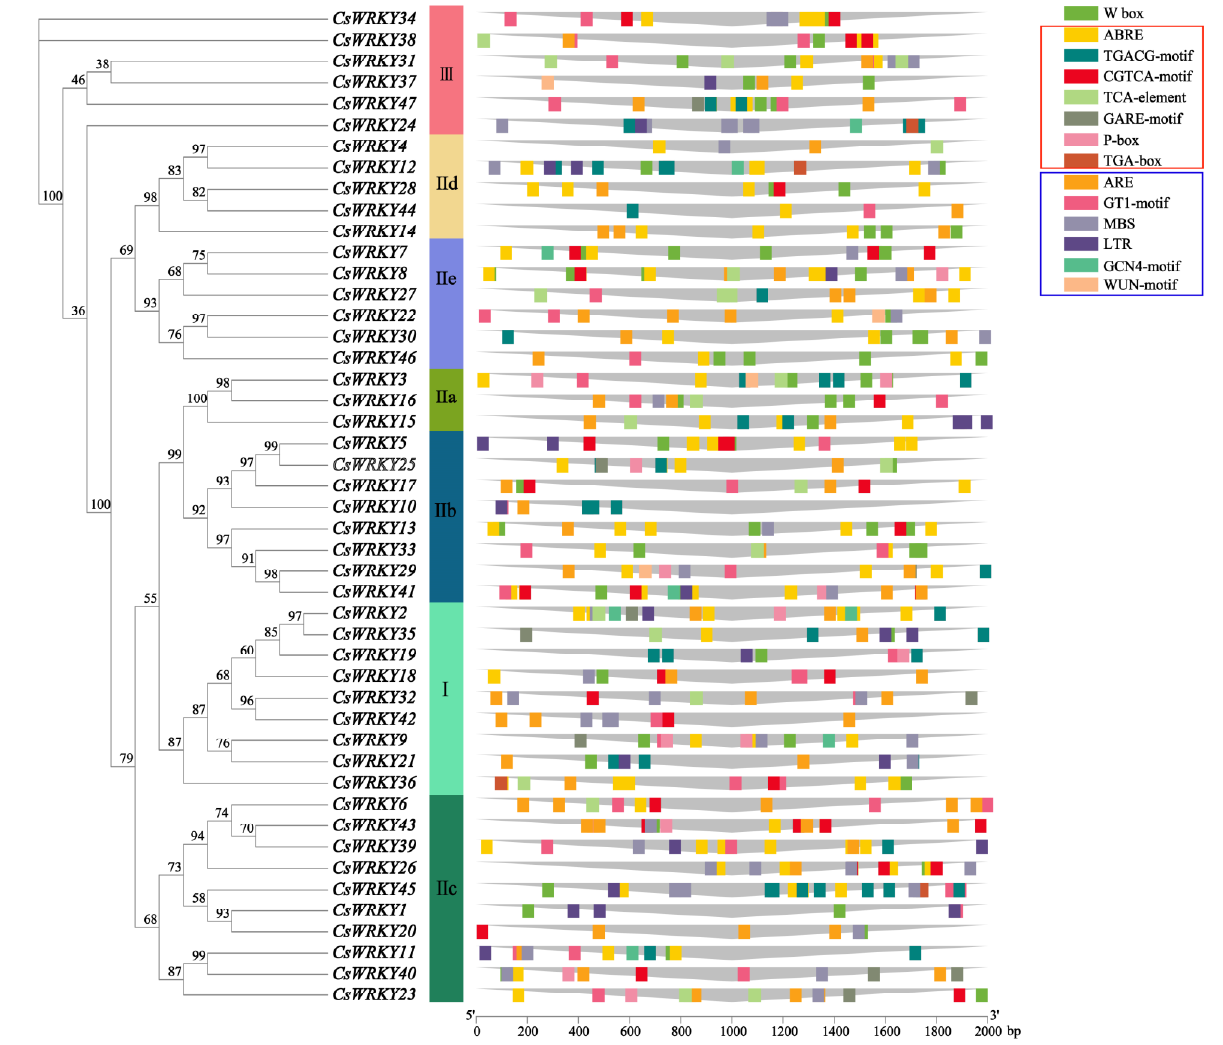
Figure 5. Cis-acting elements in the promoter of CsWRKY genes. The distribution of cis-acting elements in the upstream 2000 bp region of 47 CsWRKY genes was depicted. Seven element types in the red box were plant-induced response regulatory elements, and the six types in the blue box were stress response-related elements, with each type of element sorted from the highest to the lowest number. Different components were indicated by various shapes and colors.